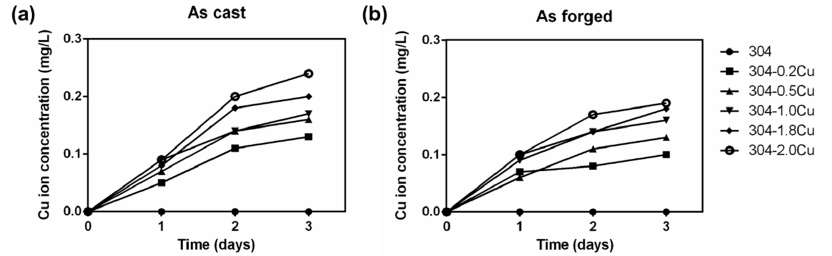
Figure 3. Release concentrations of copper ions from 304Cu stainless steel over 1, 2, and 3 days: ( a ) as cast and ( b ) as forged.